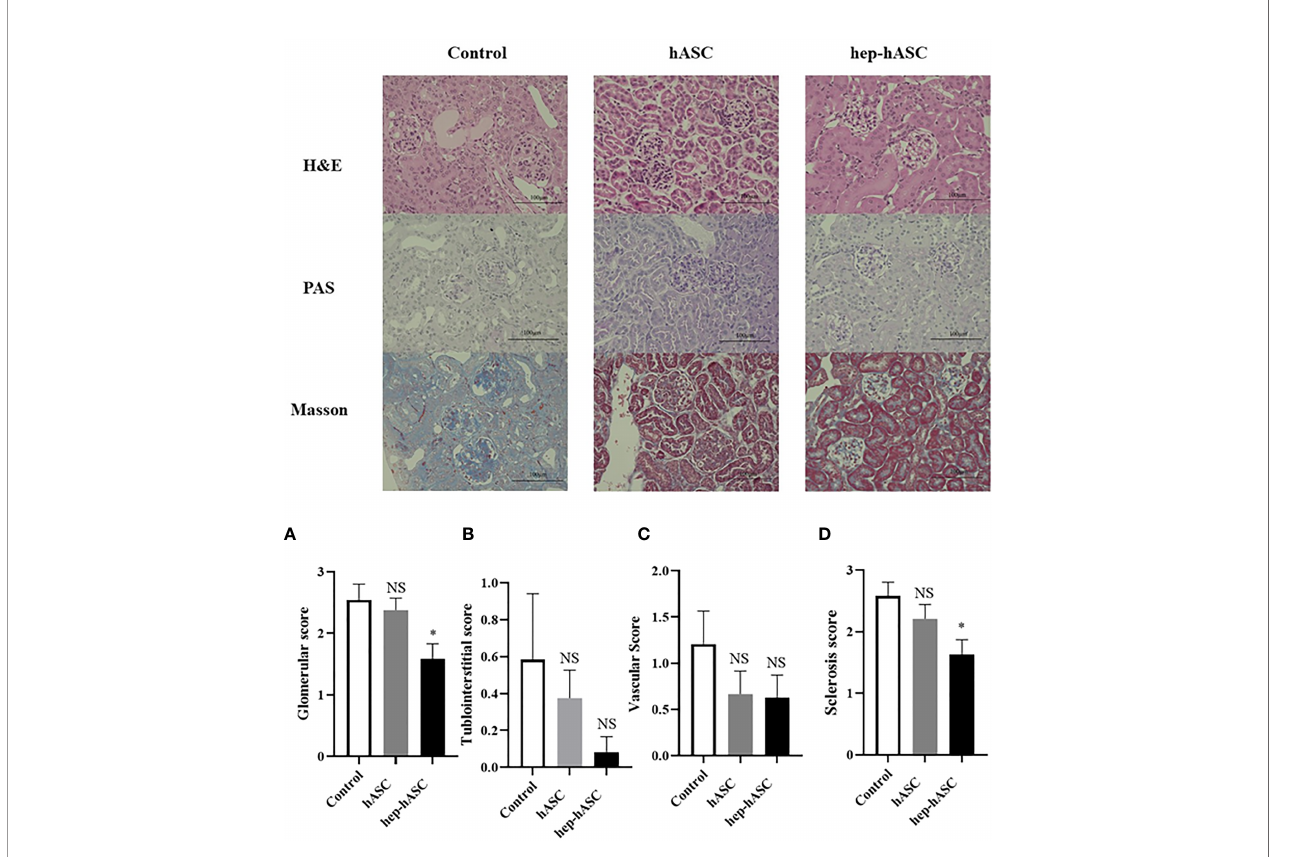
FIGURE 3 | Effect of hep-hASC transplantation on renal histology in NZB/W F1 mice. Representative images showing renal histology in control, ASCs, and hep-ASCs transplanted mice at age 26 weeks (after disease onset) were shown. Hematoxylin and eosin (H&E), periodic acid – Schiff (PAS), Masson ’ s trichrome staining (×400) were evaluated. Renal histopathology included mesangial matrix deposition, crescent formation, urinary cast. Glomerular (A) , tubulointerstitial (B) , vascular (C) , and glomerulosclerosis score (D) were graded as described in Material and Methods . Data expressed as mean ± SEM (N=12 mice per group). *P < 0.05. NS, not signi fi cant vs. control group. ASCs, adipose-derived mesenchymal stem